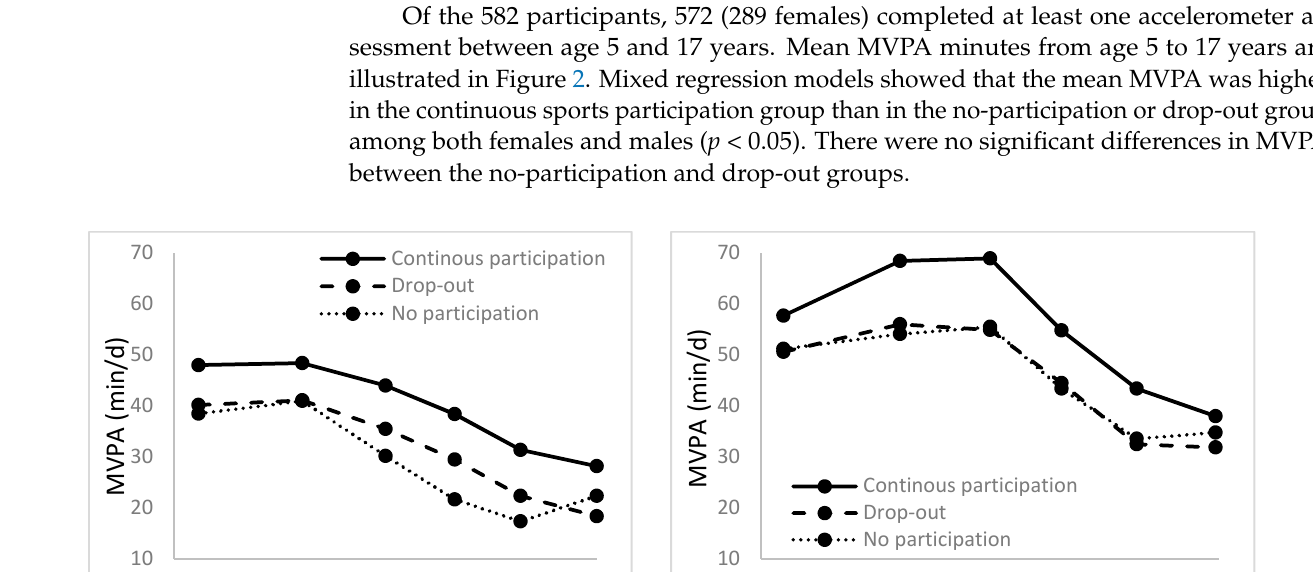
Table 1. Participant characteristics by youth sports participation patterns ( n = 582).